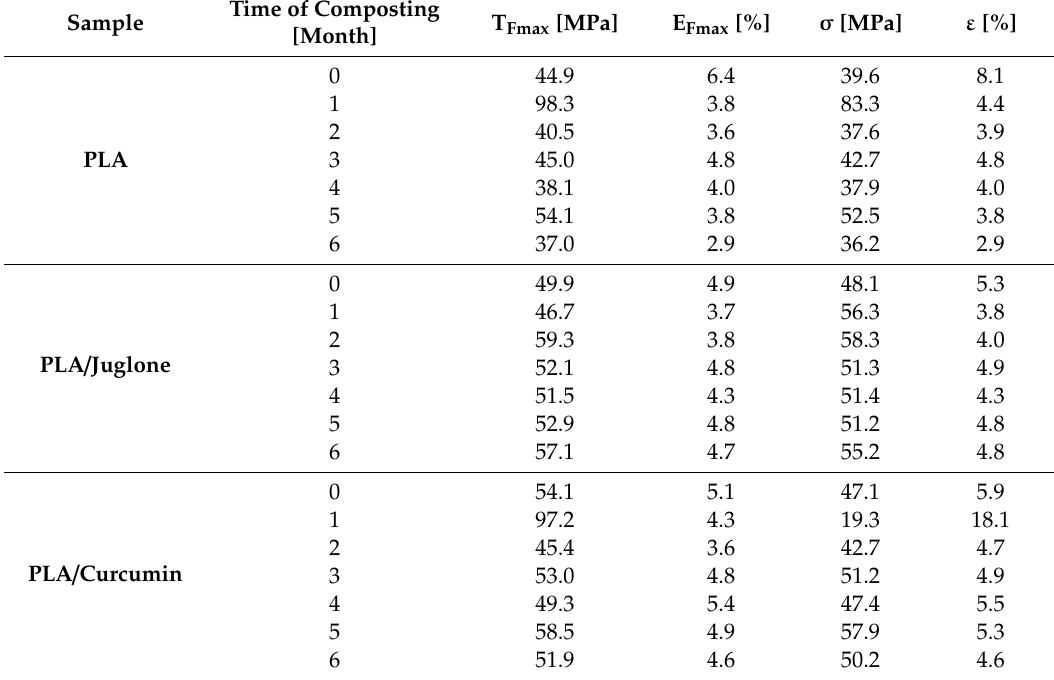
Table 3. Mechanical properties of samples based on PLA over 6 months of composting (T Fmax